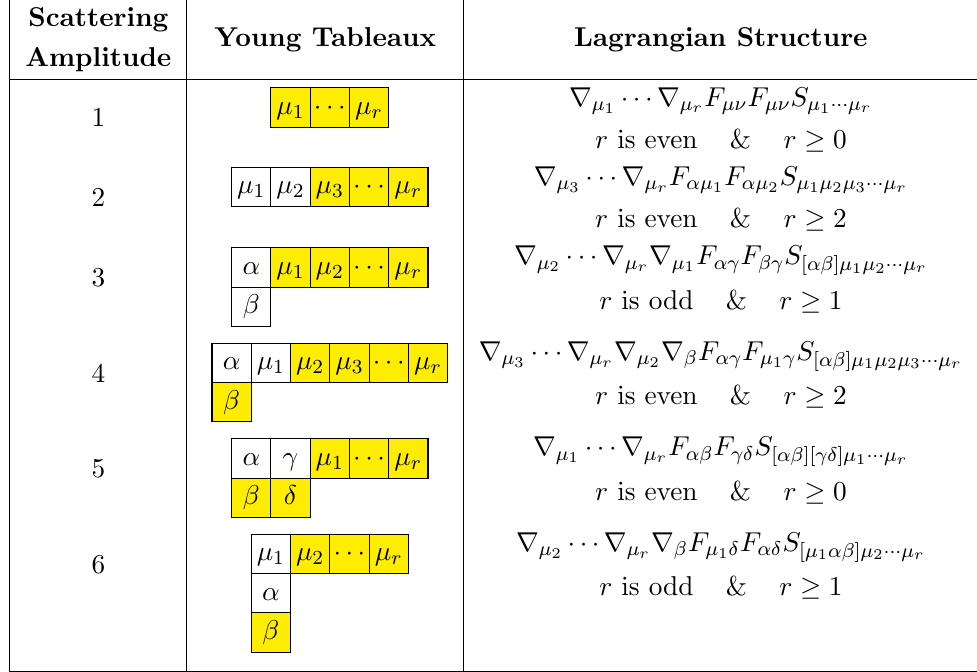
Table 1. Photons , D (cid:21) 8. The yellow shaded part of the Young’s Tableaux denotes contraction of the SO( D (cid:0) 1) tensor with k 1 (cid:0) k 2 . The Tableaux obtained after omitting all shaded boxes gives the SO( D (cid:0) 2) representation in which the fusion with photons (in later tables gravitons)